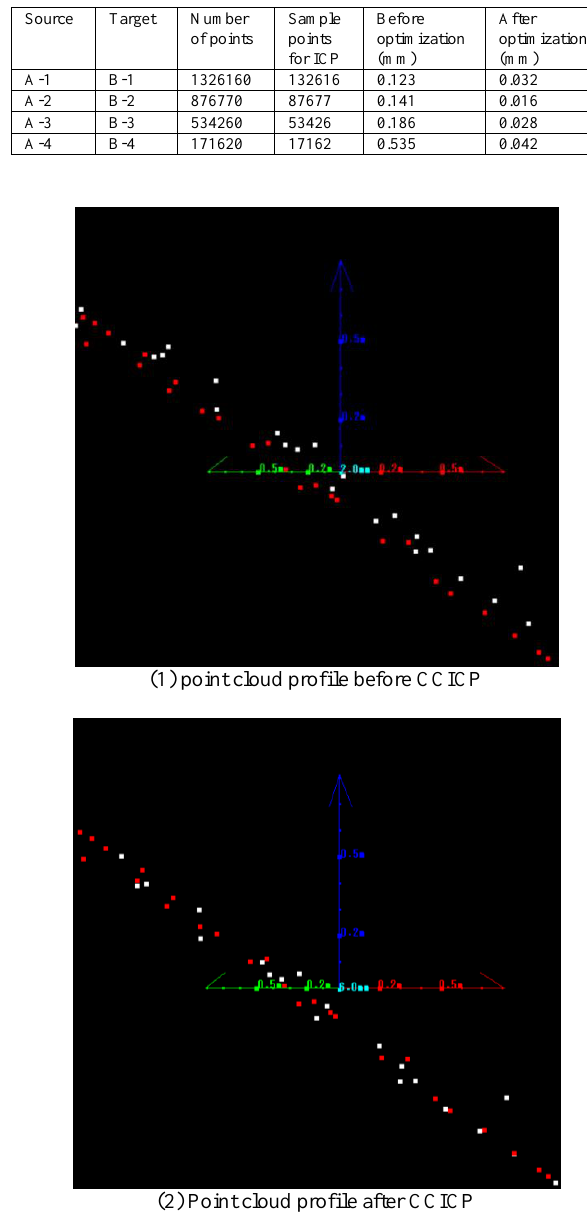
Table 4. Mean distance before/after CCICP registration